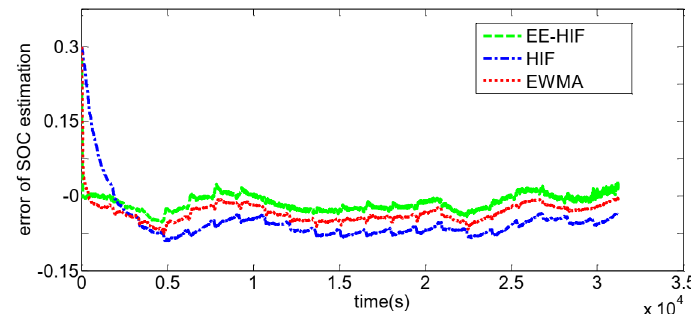
Figure 12. The estimated error curve of the three algorithms.